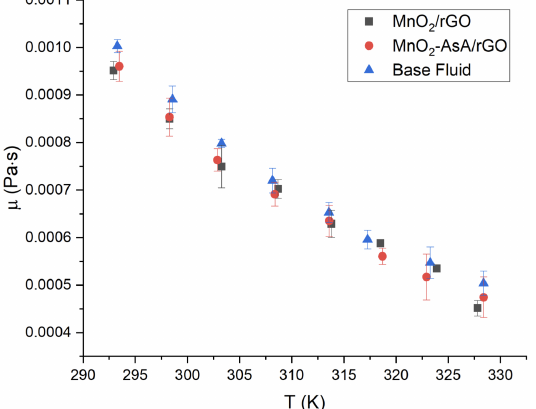
Figure 13. Dynamic viscosity versus temperature of MnO 2 /rGO nanofluids at a concentration of 0.1 wt.%. The error bars correspond to the measurements’ standard deviations.